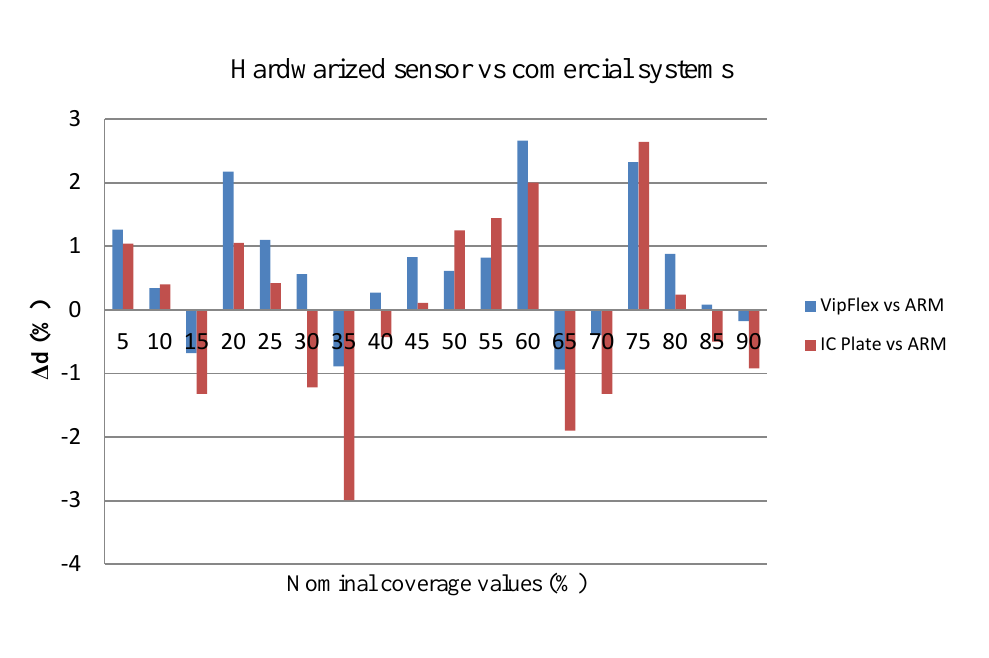
Figure 20. Comparison of nominal and measured coverage values in the hardwarized sensor based on